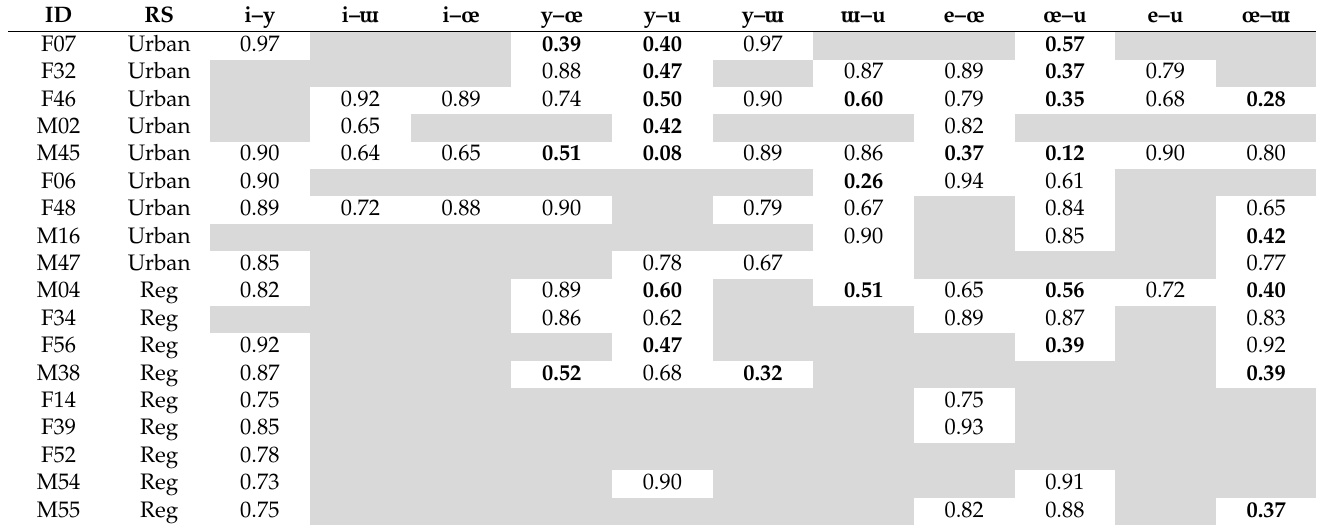
Table 5. Individual Pillai scores for overlapping vowel pairs presented by speaker ID and residence. Shaded cells indicate no visual spectral overlap in the F1/F2 vowel